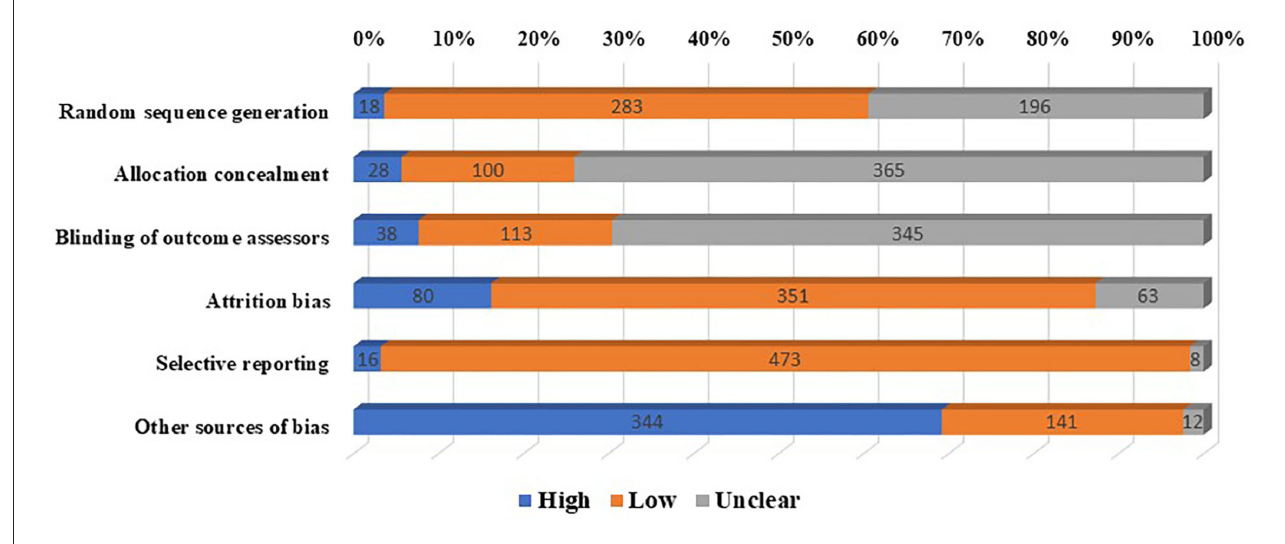
FIGURE2 Risk of bias among included trials of therapeutic patient education